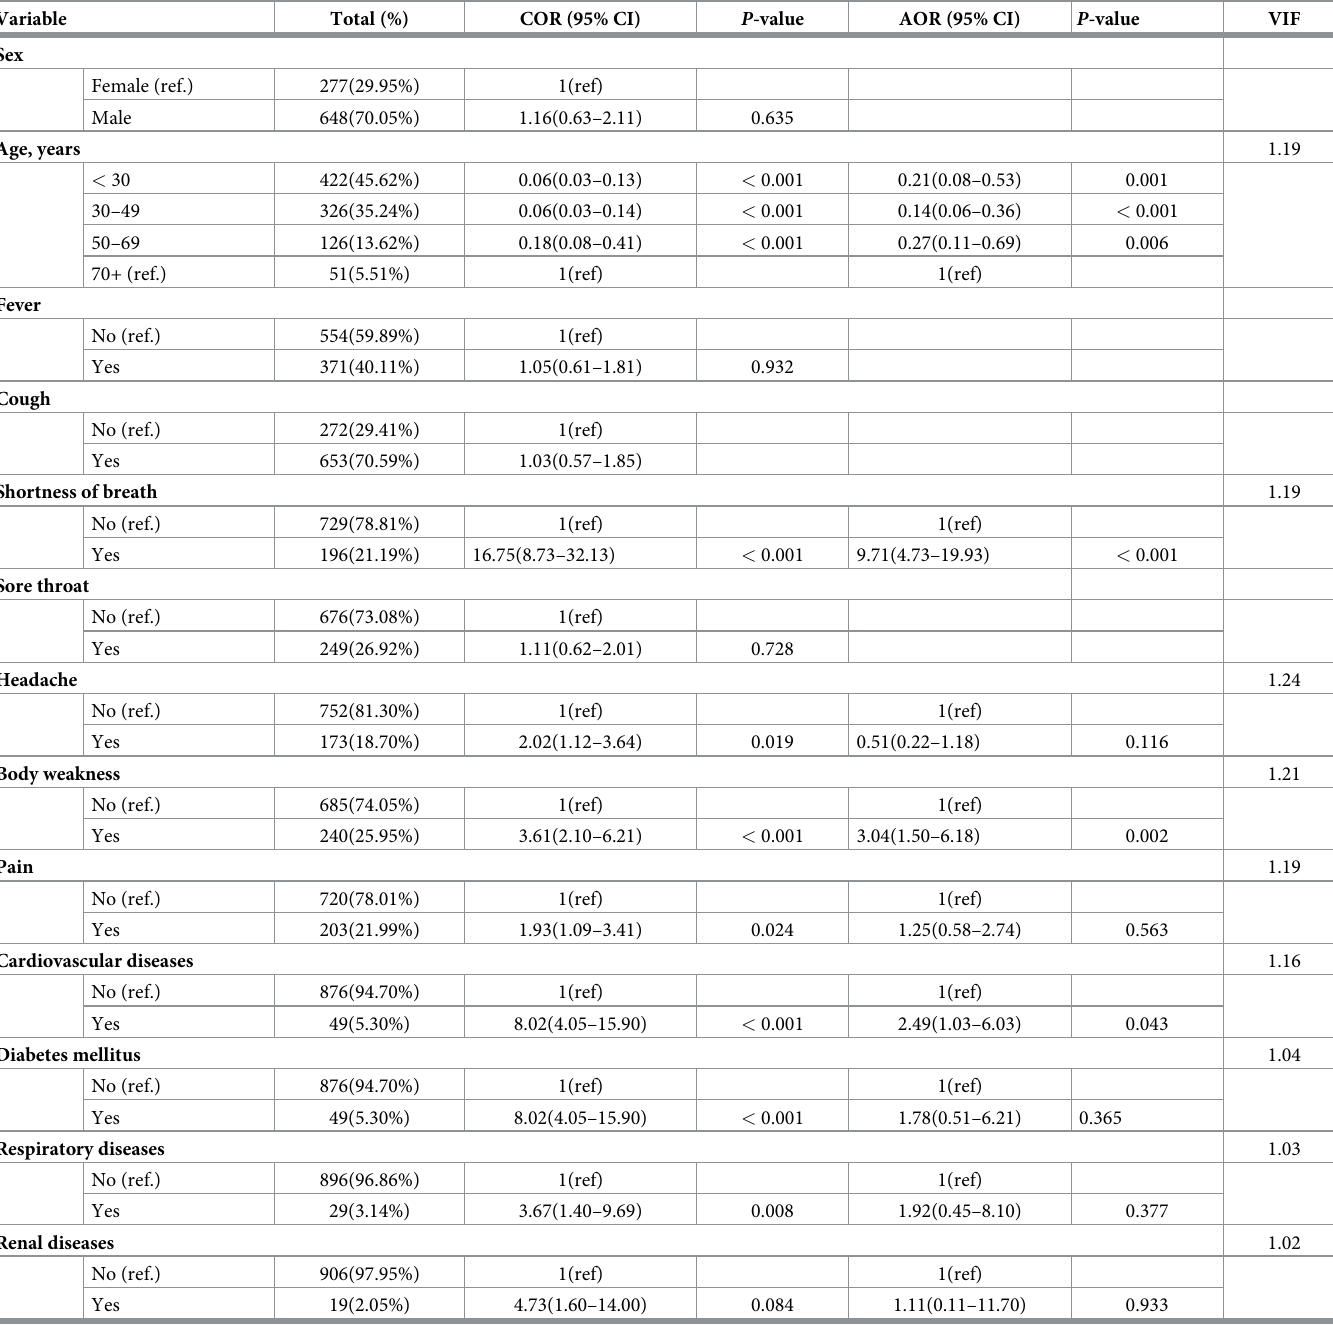
Table 3. Multivariable binary logistic analysis of factors associated with mortality among hospitalized COVID-19 patients, Tigray, Northern Ethiopia, 2020.